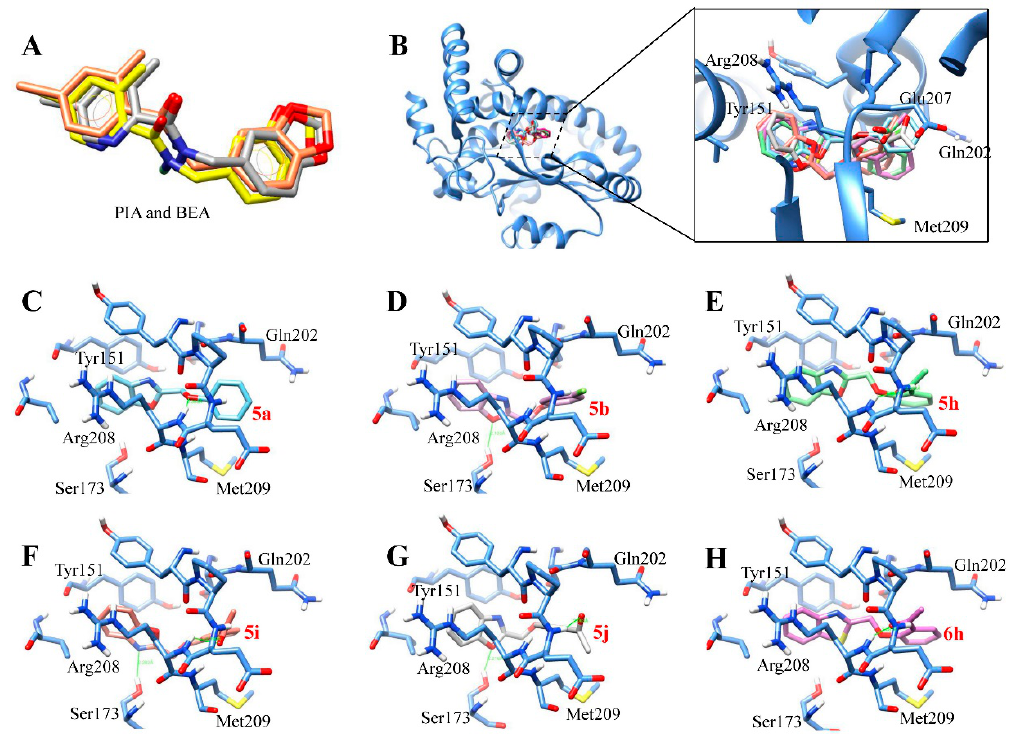
Figure 4. The binding models of the test compounds into the lipid binding pocket of Sec14p from S. cerevisiae. ( A ) Superposition of PIA (yellow) and BEA (orange) in docking resultant models with PIA in the X-ray crystallographic structure (PDB 6F0E; gray). ( B ) Overlay of the six test benzoxazole and benzothiazole derivatives. (C–H) The binding modes of the compounds (in stick model with carbon) into the active site of Sec14p: ( C ) 5a (aquamarine); ( D ) 5b (orchid); ( E) 5h (light green); ( F ) 5i (coral); ( G ) 5j (light gray); and ( H ) 6h (hot pink). Table 3. The docking results of the tested compounds. Cpd. Binding Energy (kcal/mol)